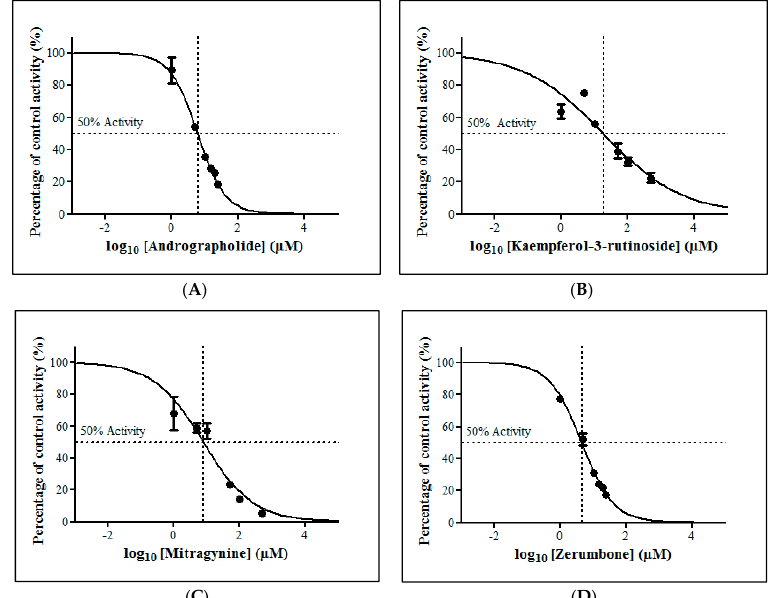
Figure 5. The inhibitory effect of ( A ) andrographolide, ( B ) kaempferol-3-rutinoside, ( C ) mitragynine and ( D ) zerumbone on zidovudine (ZDV) glucuronidation in human liver microsomes (HLM). Each point represents the mean percentage of relative ZDV-UGT2B7 specific activity over control ± standard deviation (SD) for triplicates ( n = 3). Data points were fitted to non-linear regression (curve fit) using GraphPad Prism 5.01 to determine an IC 50 value. Goodness of fit R 2 values were greater than 0.9.